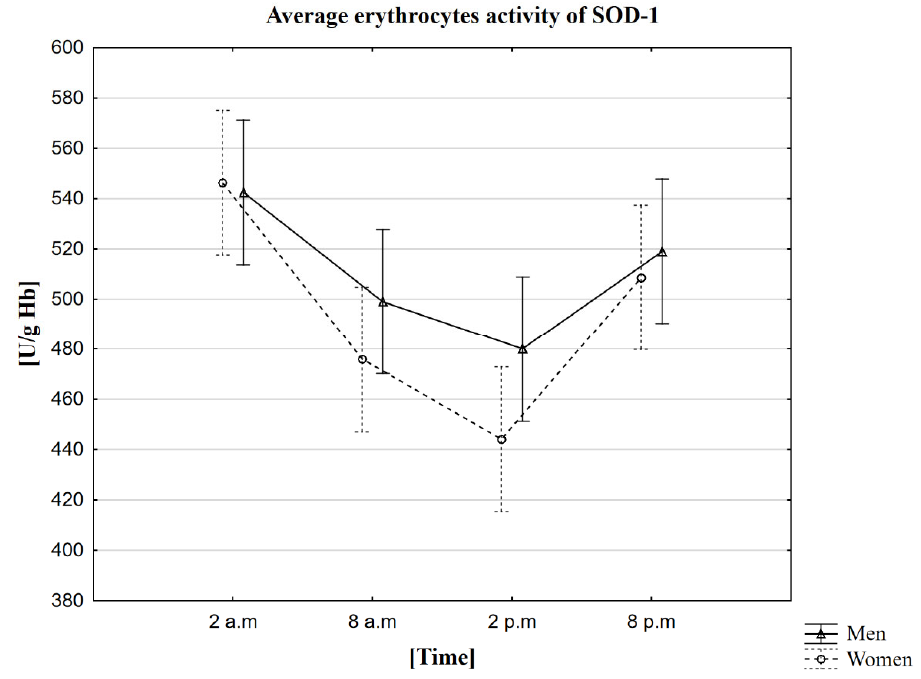
Figure 2. Average erythrocytes activity of SOD ‐ 1 in men and women at different sampling time points. Data presented as mean ± 95% confidence interval. MANOVA ‐ type analysis ( p = 0.56135). Table 4. Parameters describing the activity of catalase (CAT) in women and men including the time of blood collection (U/g